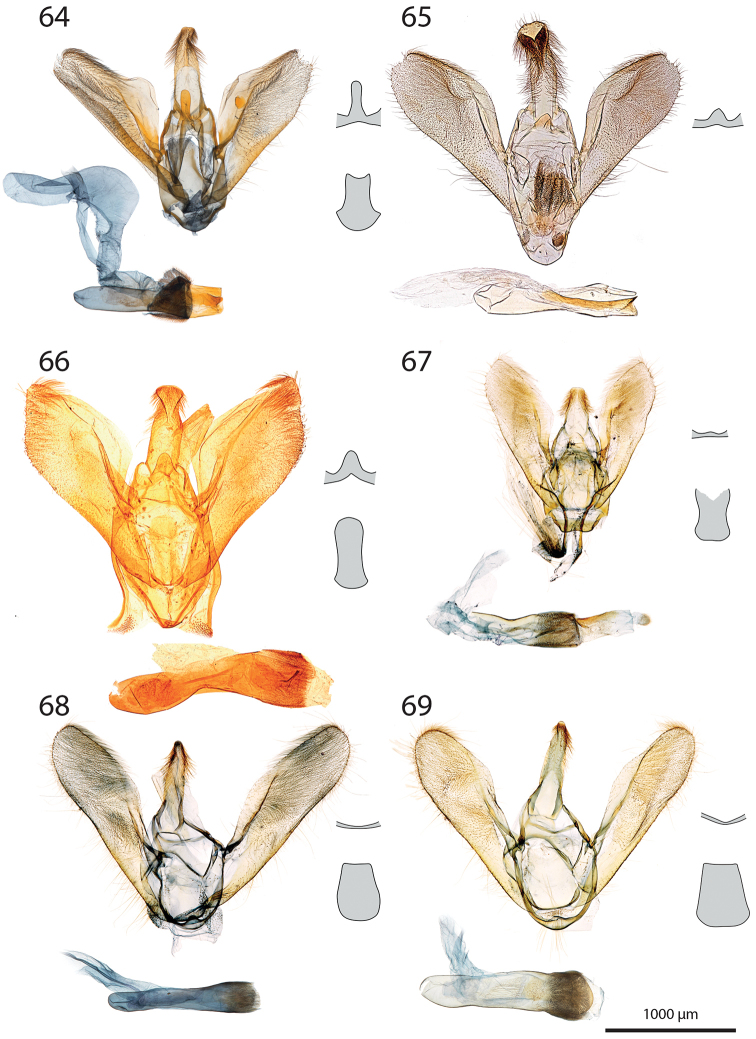
male genitalia features of Hoploscopa. 64Hoploscopa
subvariegata, TL534 ♂ 65Hoploscopa
persimilis, lectotype, Pyralidae Brit. Mus. Slide N° BMNH20255 ♂ (no juxta drawing) 66Hoploscopa
diffusa, holotype, Pyralidae Brit. Mus. Slide N° BMNH1014 ♂ 67Hoploscopa
triangulifera, TL711 ♂ 68Hoploscopa
astrapias, TL724 ♂ 69Hoploscopa
anamesa, TL727 ♂.